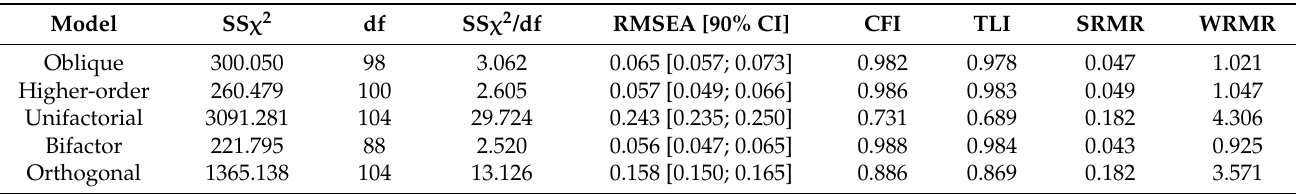
Table 3. Fit indices for confirmatory factor analysis